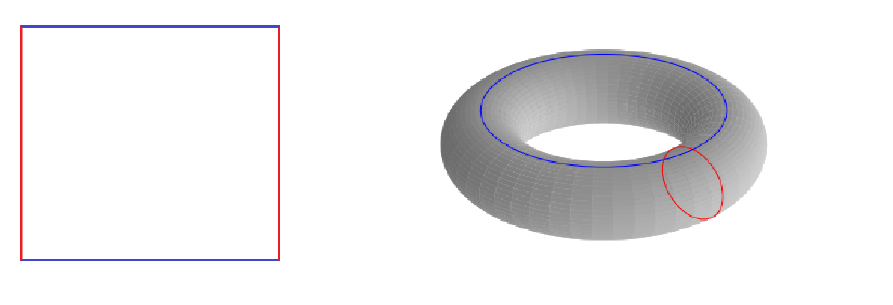
Figure 1. Plane torus with the welded opposite sides (red and blue in on-line version).